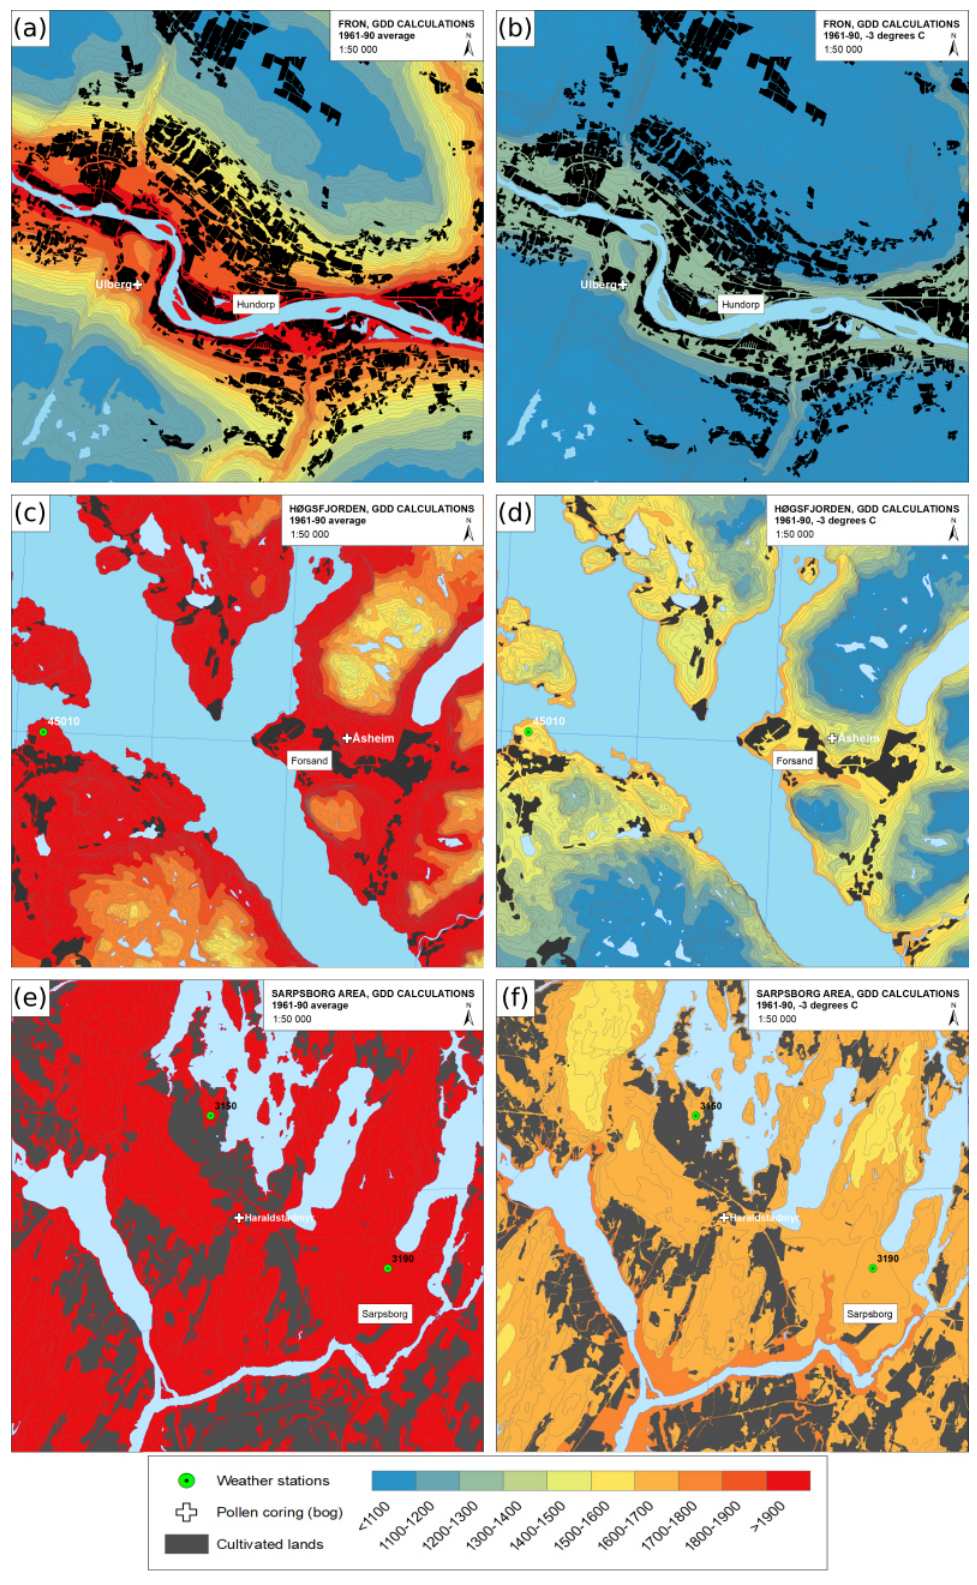
Figure 7. Growing degree day maps for 1961–1990 for (a) Fron, (c) Høgsfjorden, and (e) Sarpsborg and with a 3 ◦ C cooling compared to the 1961–1990 mean for (b) Fron, (d) Høgsfjorden, and (f) Sarpsborg. Clim. Past, 19, 357–398, 2023